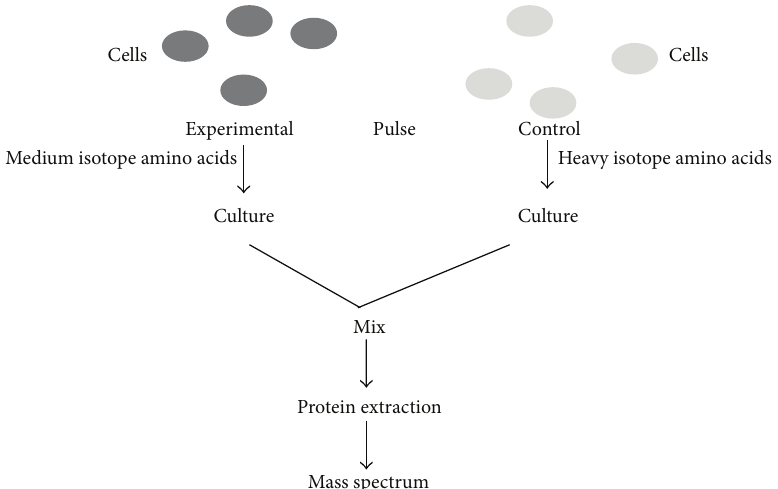
Figure 5: Schematic representation of pulsed SILAC. Proteins of the culture medium of control and experimental sample are labelled with heavy and medium isotopes, respectively, by adding them to growth medium. After short time comparison of heavy and medium isotope signal intensities miRNA target mRNA will be